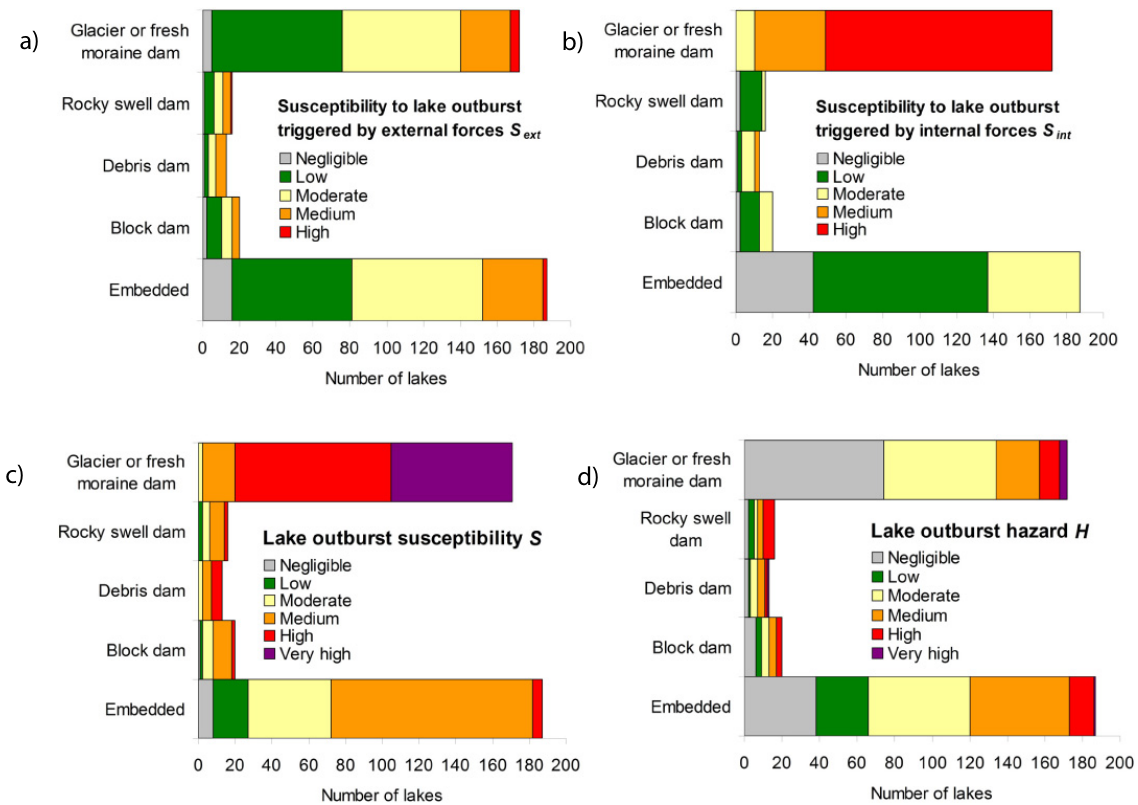
Fig. 7. (a) Susceptibility to lake outburst triggered by external forces S ext . (b) Susceptibility to lake outburst triggered by internal forces S int . (c) Combined lake outburst susceptibility S . (d) Lake outburst hazard H